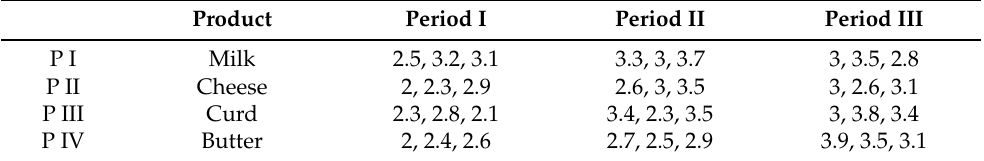
Table A4. Holding cost at destination/retailers.